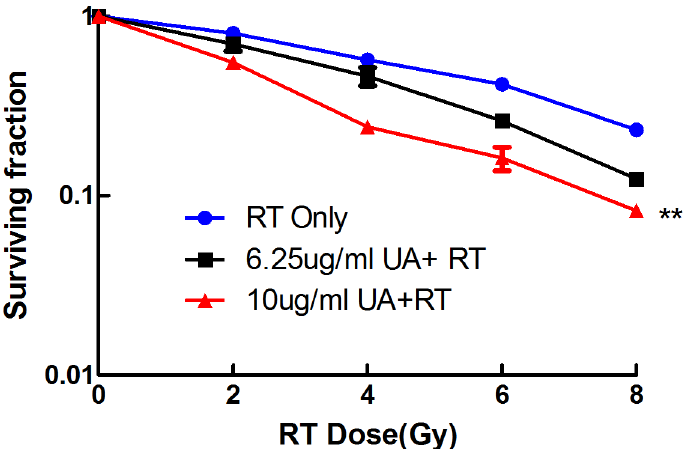
Fig 2. The radiosensitization effects of UA in BGC-823 cells. Radiosensitivity was determined by clonogenic survival assay. Surviving fraction of the combined group were significantly decreased compared with the irradiation group ( ** p <